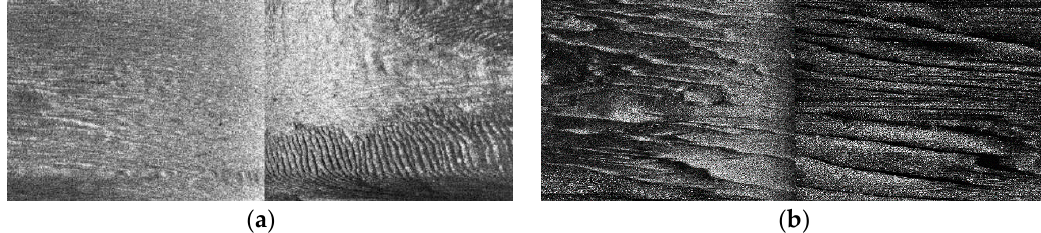
Figure 10. TVG correction for example SSS imaging. ( a ) The corrected example SSS imaging 1. ( b ) The corrected example SSS imaging 2.